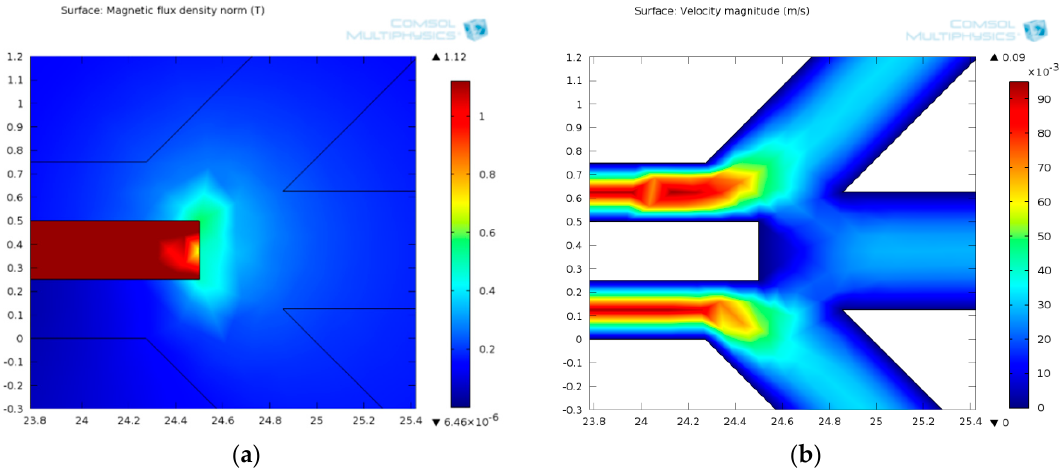
Figure 10. Surface plots: ( a ) Magnetic field and ( b ) velocity field at the sharp corner of the microfluidic channel.